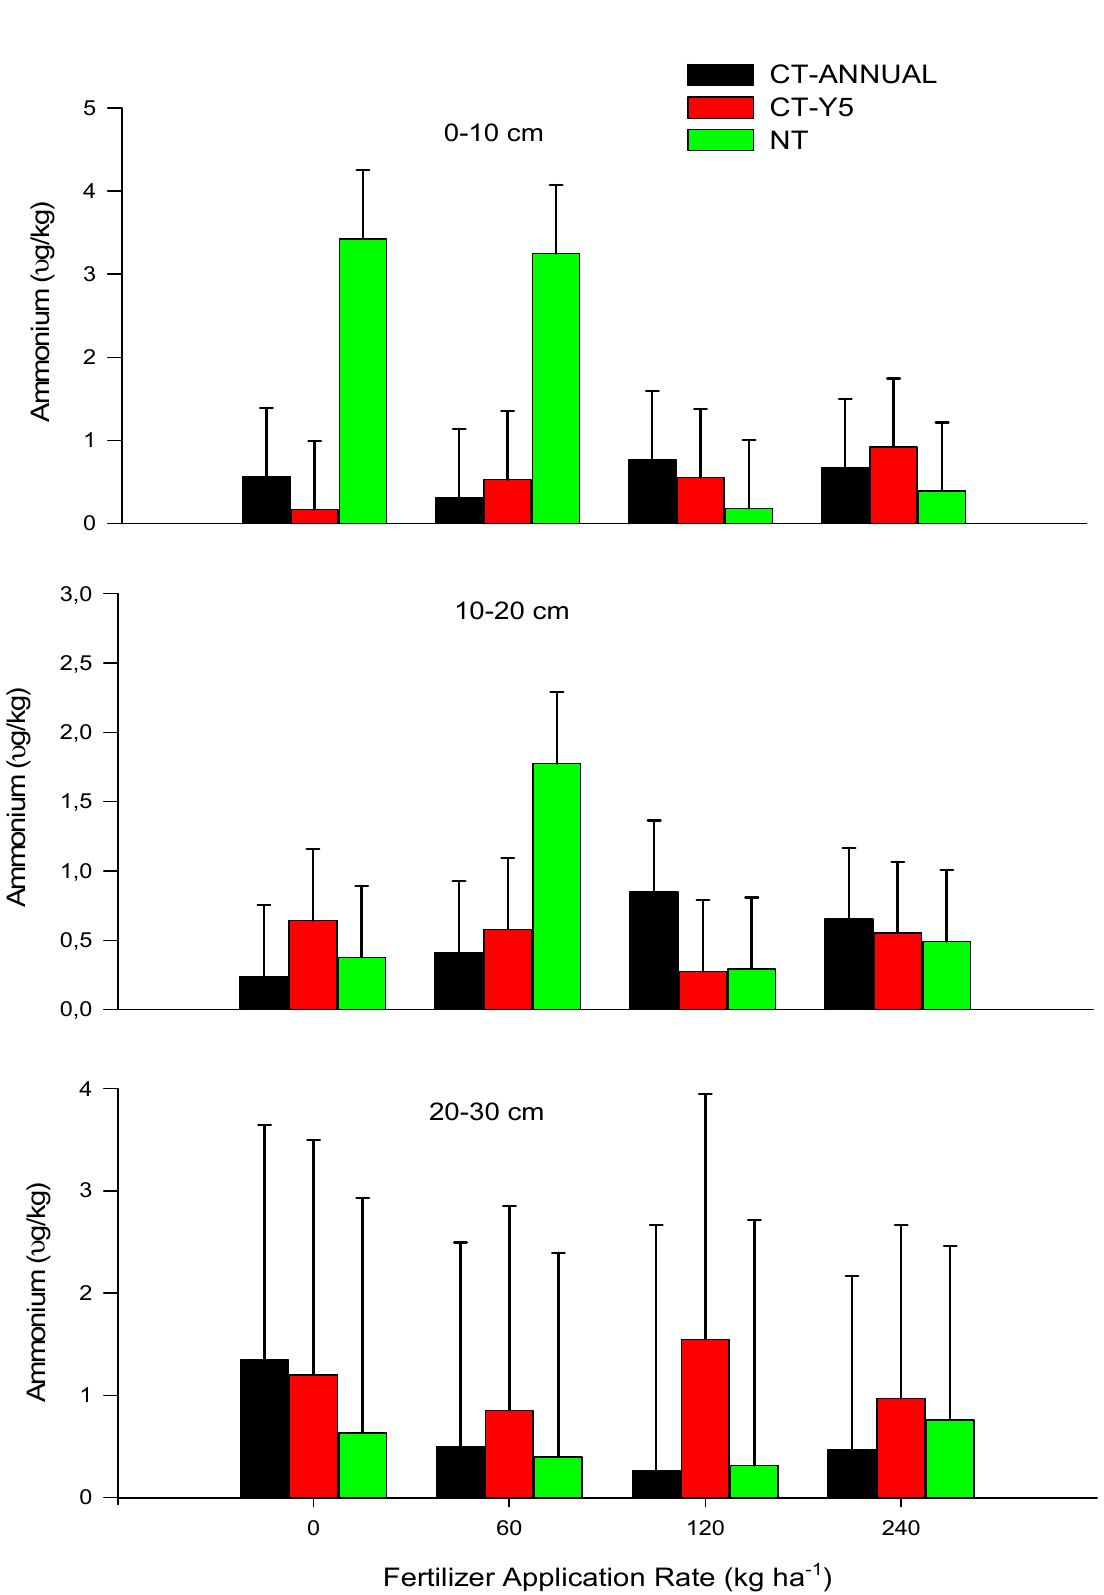
Figure 3. Contents of ammonium-N according to depth under different tillage techniques and urea fertilizer application rates.